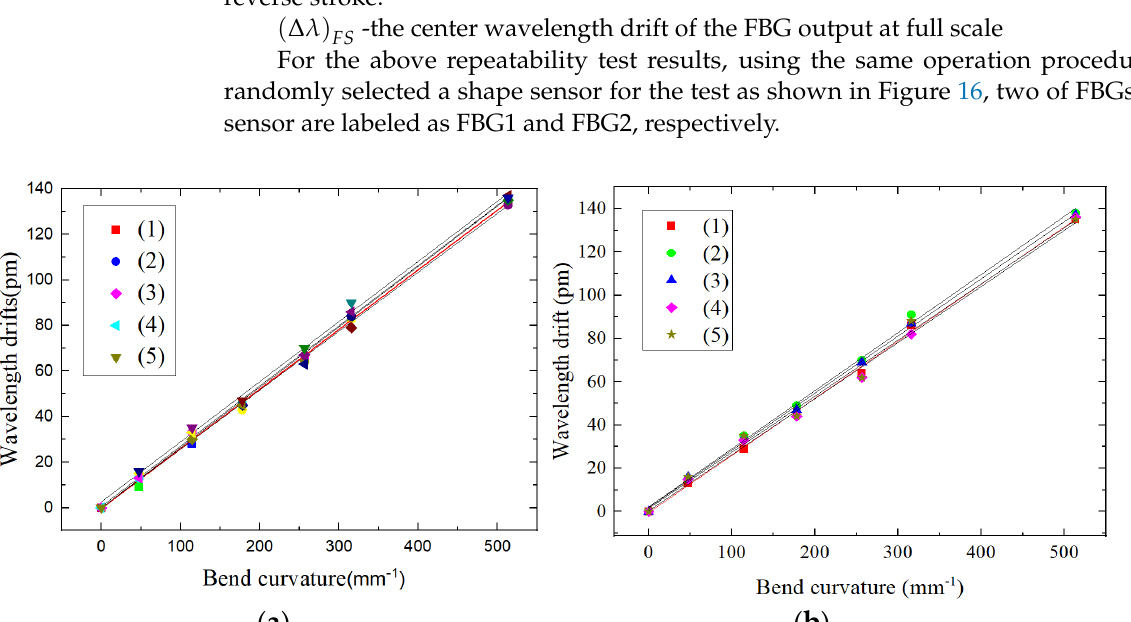
( b ) Figure 17. Shape sensor FBG hysteresis error analysis: ( a ) FBG3 center wavelength drift in for- ward-reverse stroke, ( b ) FBG4 center wavelength drift in forward-reverse stroke. The hysteresis errors of FBG3 and FBG4 are calculated from the hysteresis error formula. 𝑒 (cid:3009)(cid:2871) = ∆(cid:3090) (cid:3288)(cid:3276)(cid:3299) (∆(cid:3090)) (cid:3255)(cid:3268) × 100% = (cid:2871) (cid:2869)(cid:2870)(cid:2871) × 100% = 2.43 %